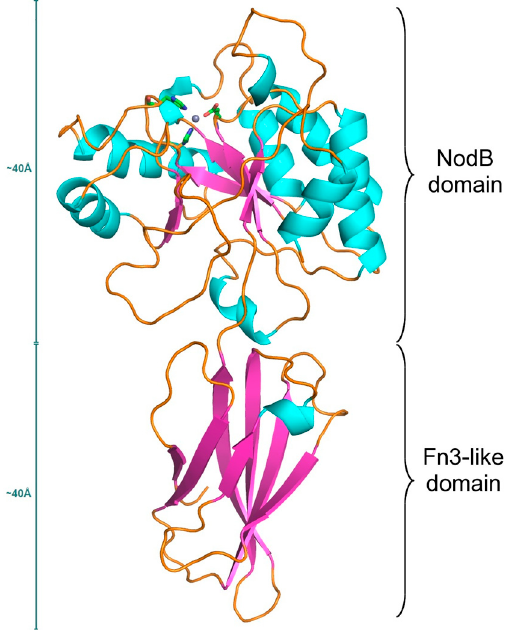
Figure 1. Ribbon diagram of the Ba0331 polysaccharide deacetylase (PDA) protein architecture showing the two distinct domains. Helices are represented as cyan ribbons, β -strands are in magenta and loops are shown as orange strings. The Zn ion is shown as a grey sphere with the coordinating amino acid residues (Asp213, His271 and His275) in stick representation.